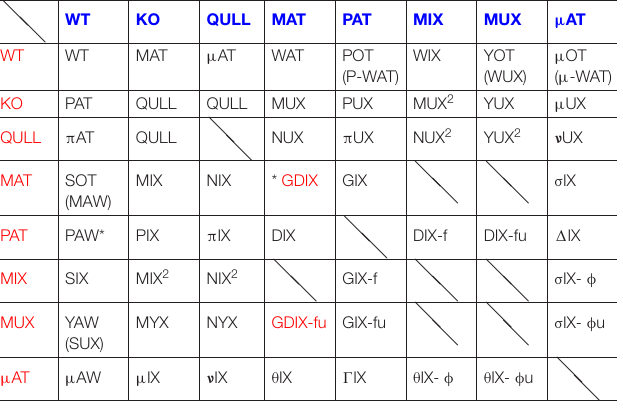
Male specimens (in column) are represented in blue. Female specimens (in line) are represented in red.